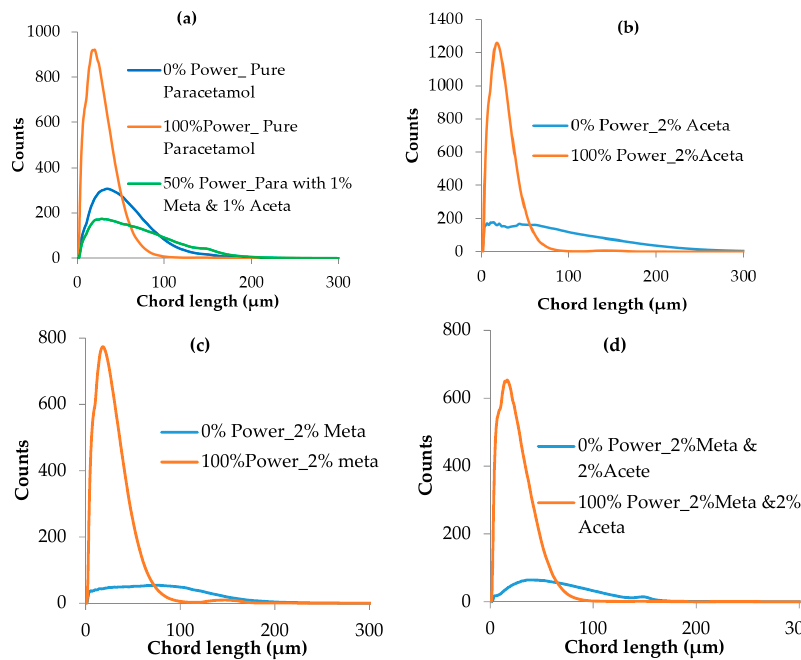
Figure 6. Particle size distribution of paracetamol crystals measured in situ at the end of crystallisation in the presence of impurities using an FBRM with and without the use of ultrasound ( a ) Pure paracetamol and 1% Metacetamol and 1% Acetanilide; ( b ) 2% acetanilide; ( c ) 2% Metacetamol; ( d ) both 2% Acetanilide and 2% Metacetamol.